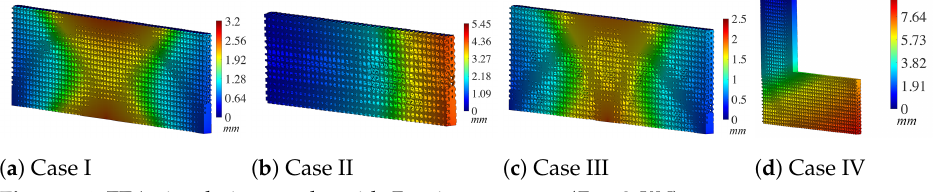
Figure 14. FEA simulation results with F 1 microstructure ( F = 3 KN